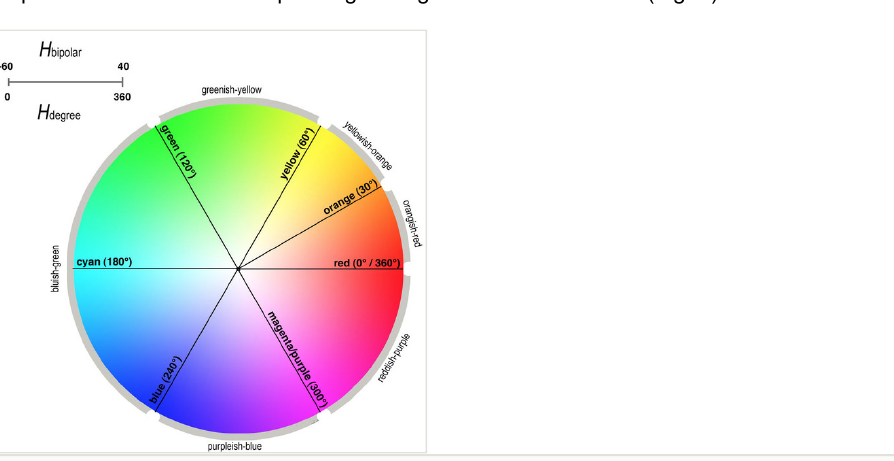
Figure 6. Graphical representation of color Hue values on the color wheel, with modified PATO